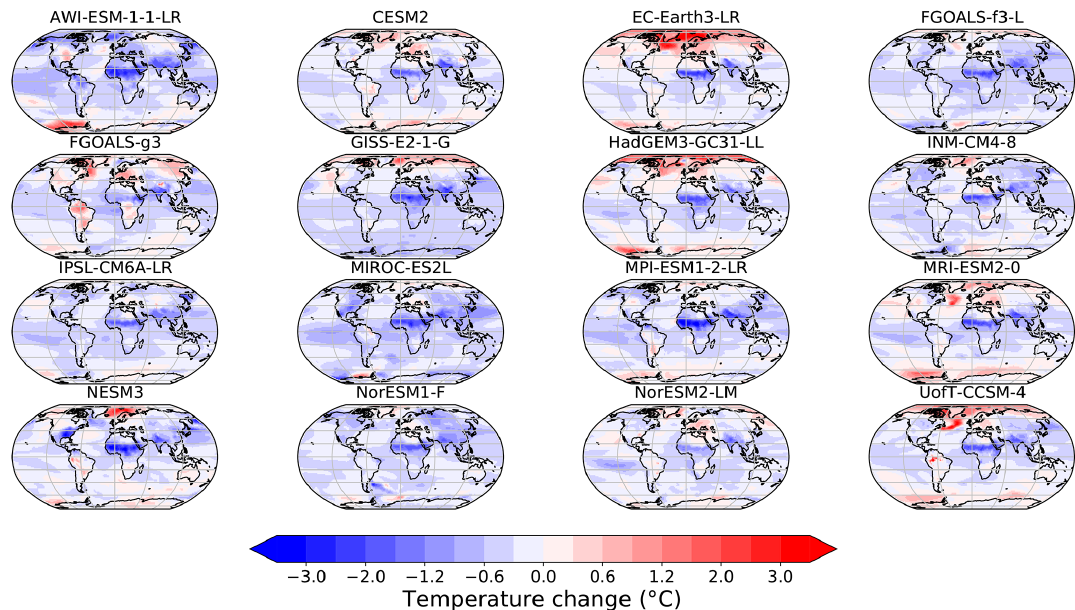
Figure 3. Annual mean surface temperature change ( ◦ C) in midHolocene as simulated by individual models that feature Fig. 4 in this work and Fig. 1a in Brierley et al. (2020). Anomalies have been regridded to a 1 ◦ by 1 ◦ resolution.